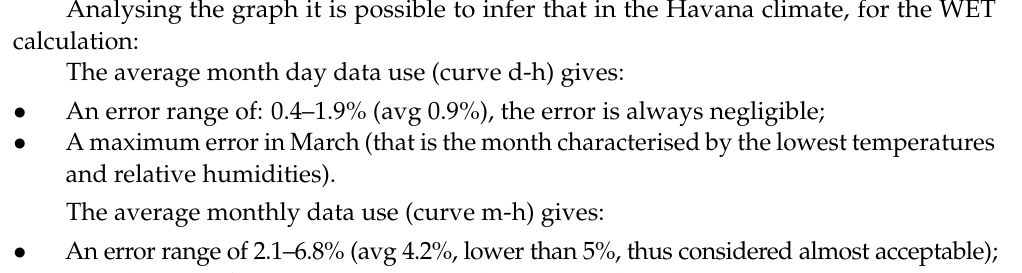
Figure 6. Havana MHI values ( A ) and percentage error ( B